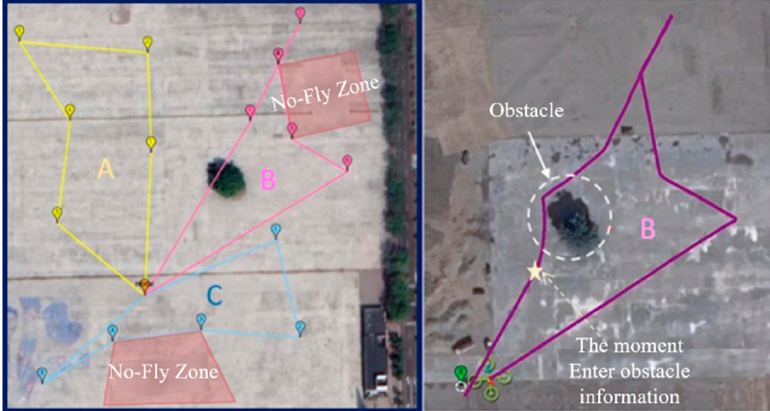
Figure 22. Programmed group route ( left ) and real-time avoidance simulation ( right ).